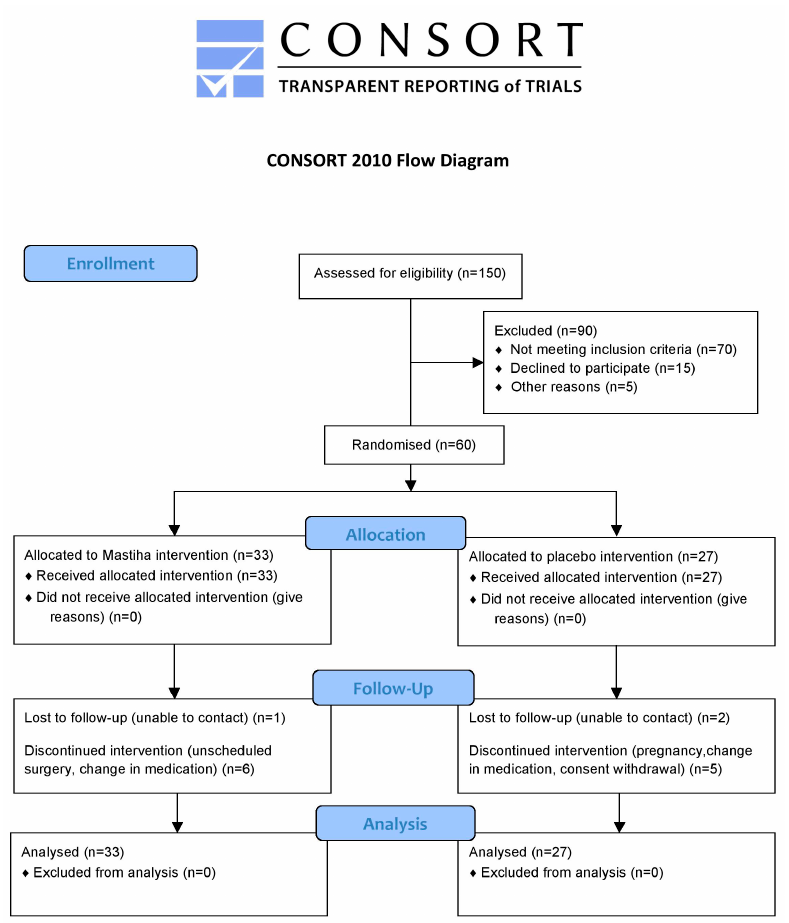
Figure A1. CONSORT 2010 flow